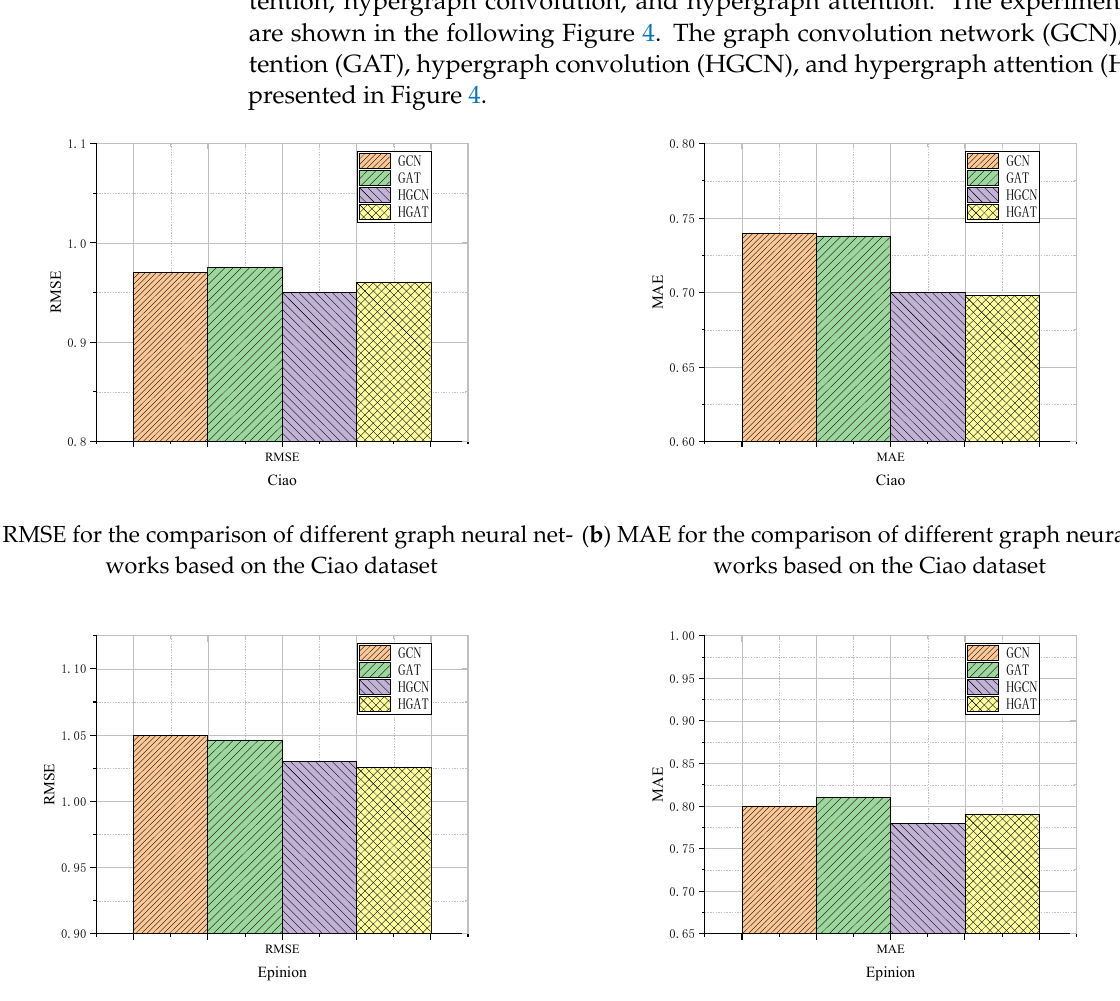
Figure 4. Experiments and comparative analysis of graph convolution, graph attention, hypergraph convolution, and hypergraph attention ( a ) RMSE for the comparison of different graph neural networks based on the Ciao dataset ( b ) MAE for the comparison of different graph neural networks based on the Ciao dataset ( c ) RMSE for the comparison of different graph neural networks based on the Epinions dataset ( d ) MAE for the comparison of different graph neural networks based on the Ciao dataset.